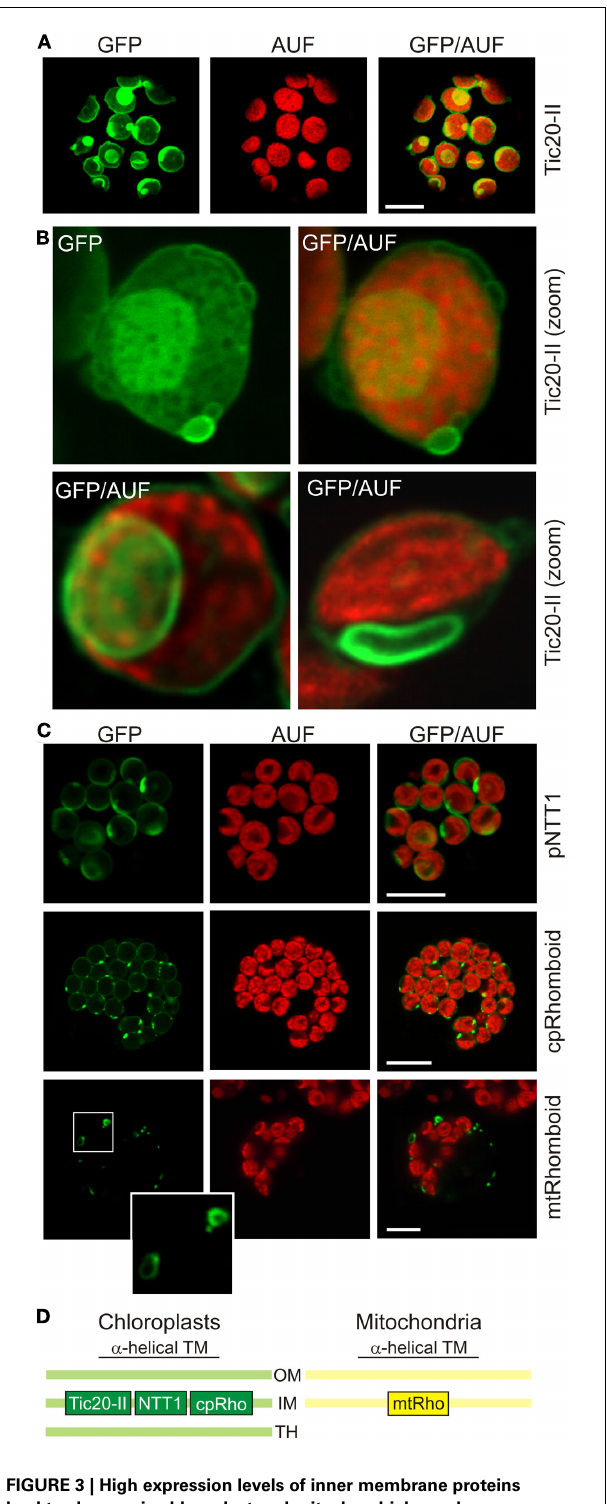
FIGURE 3 | High expression levels of inner membrane proteins lead to changes in chloroplast and mitochondrial membrane morphology. (A) The chloroplast inner envelope protein at Tic20-II was fused to GFP and expressed in A. thaliana mesophyll protoplasts under control of a 35S promoter. GFP fluorescence